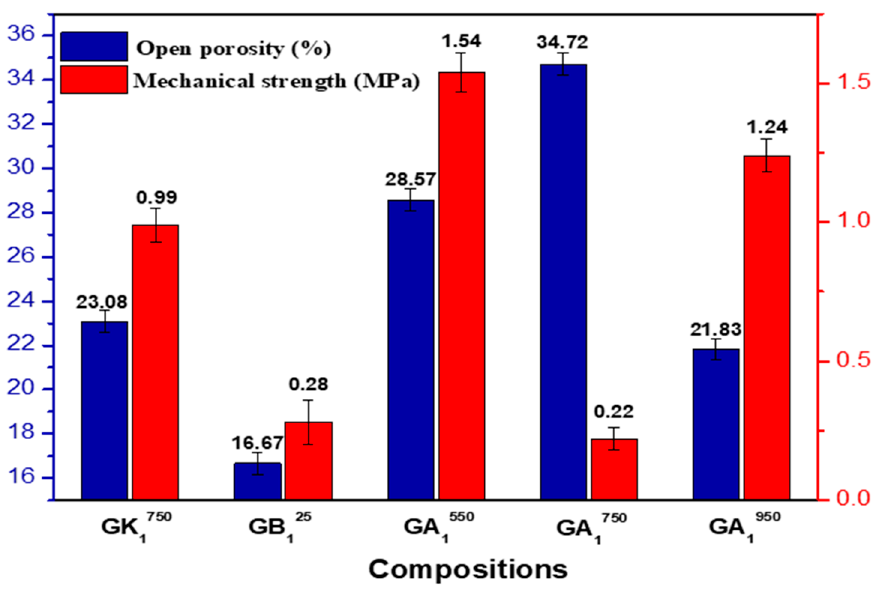
Figure 17. Evolution of the mechanical strength and the open porosity of the synthesized geopoly- meric materials according to the calcination temperatures of the clay.